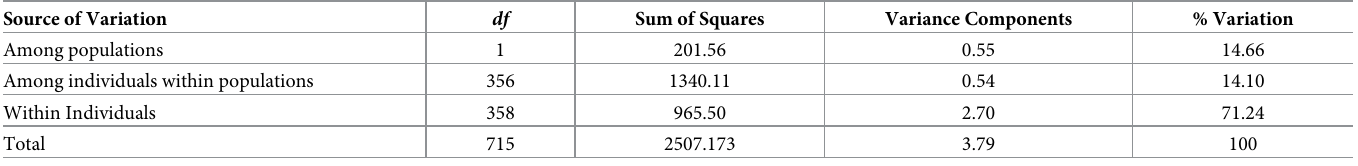
Microsatellite genotype data is available at https://doi.org/10.6084/m9.figshare.6972518.v1. Table 3. Results of Analysis of Molecular Variance (AMOVA) for genetic clusters 1 and 2 in the Bombus fervidus species complex (n = 330) based on allele frequen- cies of 13 loci. Source of Variation df Sum of Squares Variance Components % Variation Among populations 1 201.56 0.55 14.66 Among individuals within populations 356 1340.11 0.54 14.10 Within Individuals 358 965.50 2.70 71.24 Total 715 2507.173 3.79 100 F IS = 0.17, F ST = 0.15, F IT = 0.29, (all p < 0.001)